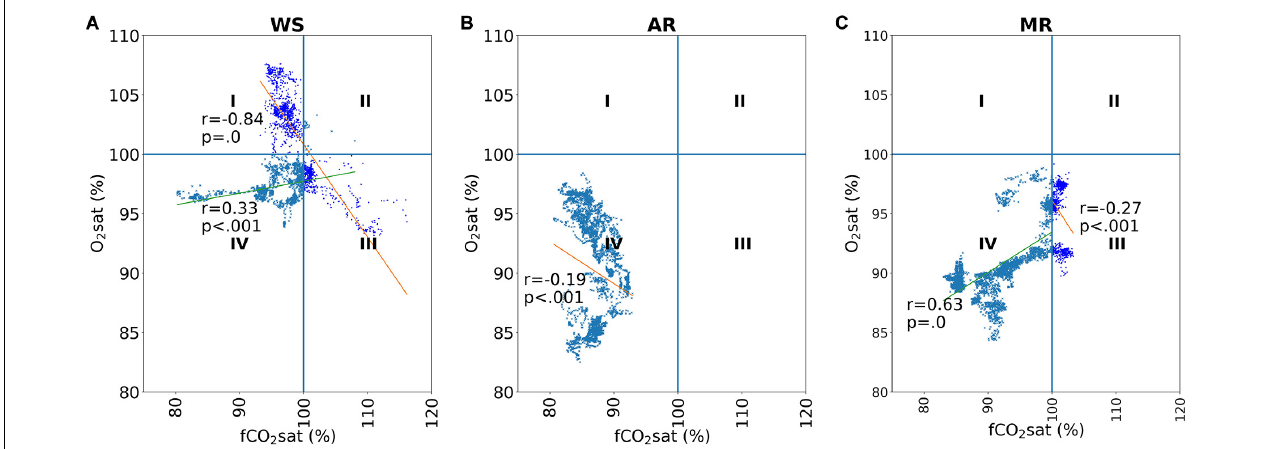
FIGURE 5 | Percentage O 2 saturation (O 2 sat) versus percentage fCO 2 (fCO 2 sat) for the three regions. (A) WS region, (B) AR region, and (C) MR region. Vertical and horizontal sky-blue lines represent 100% saturation levels fCO 2 ssw and O 2 , respectively. Intersection points of the two lines denote the origin and 100% air-saturation of fCO 2 and O 2 . I, II, III, IV represent the four quadrants. Distribution of observations driven dominantly by photosynthesis (in I) and respiration/remineralization and/or upwelling (in III) are represented by deep blue colors while those driven dominantly by warming/cooling effect (in II and IV) are represented by sky blue